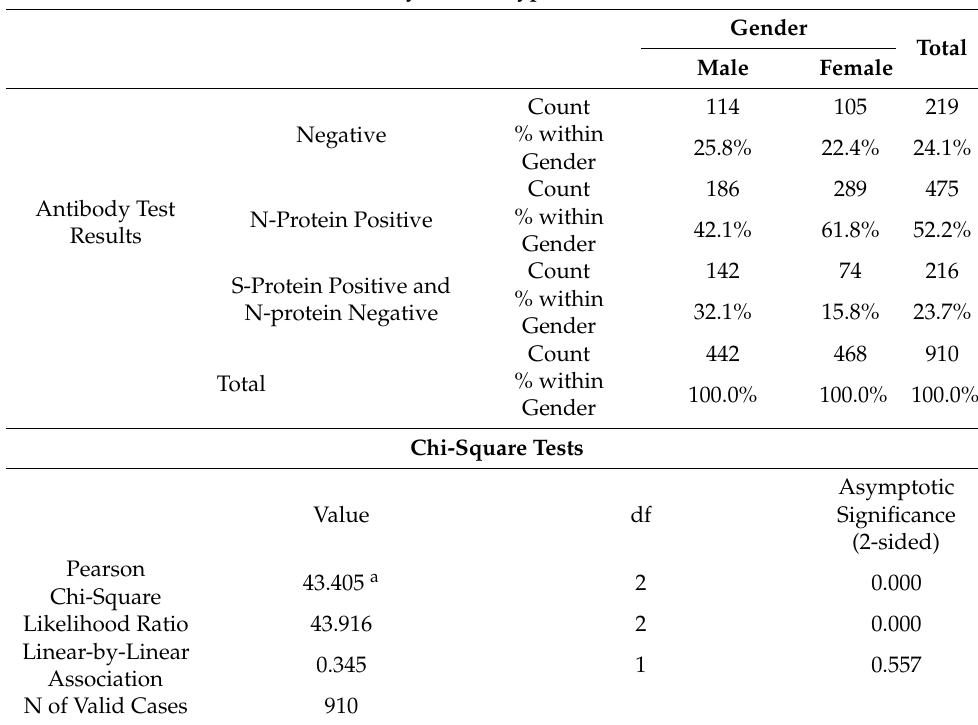
Table 4. Antibody test results by Protein Type and Gender.